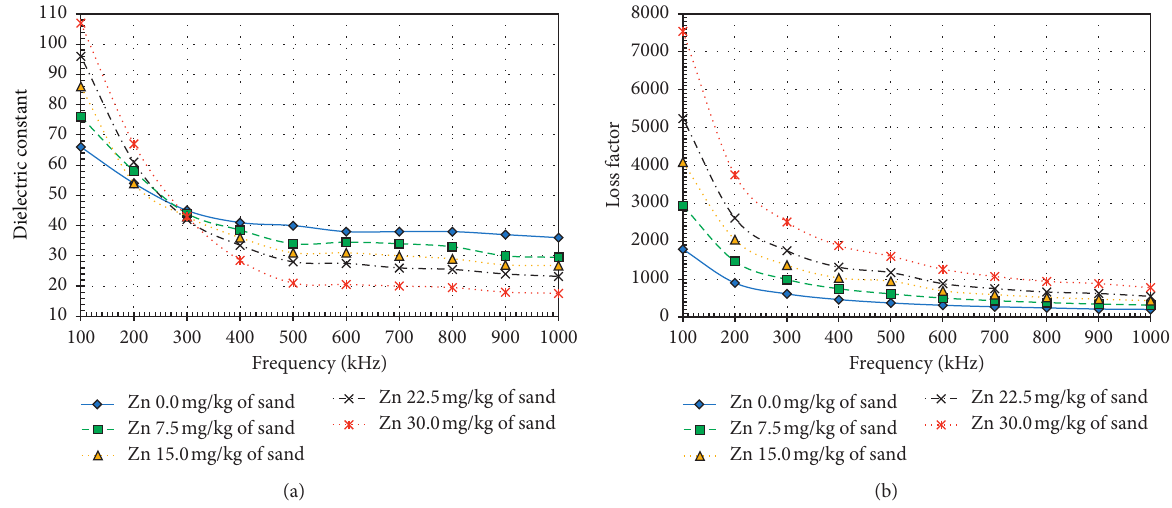
Figure 6: Complex permittivity of sand contaminated with Zn. (a) Dielectric constant versus frequency. (b) Loss factor versus